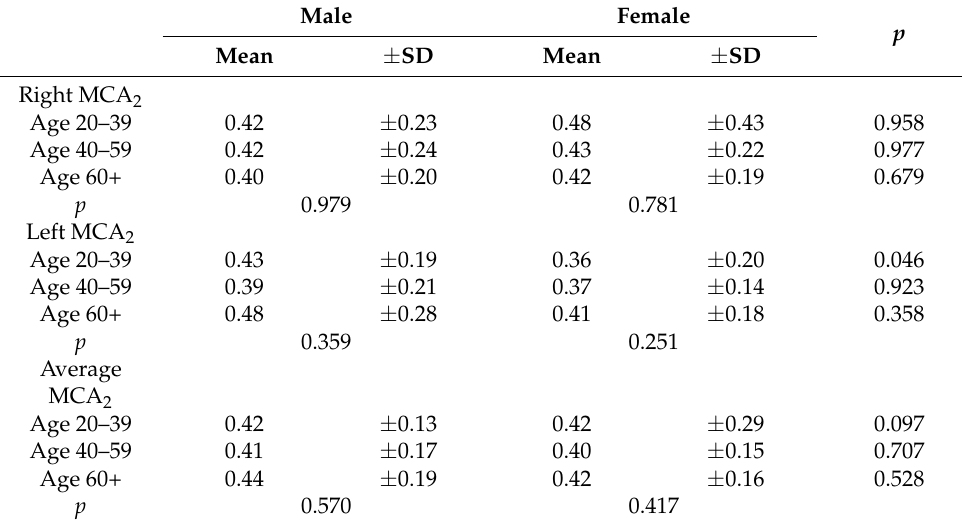
Table 4. Second minimal cross-sectional area (MCA 2 , cm 2 ).